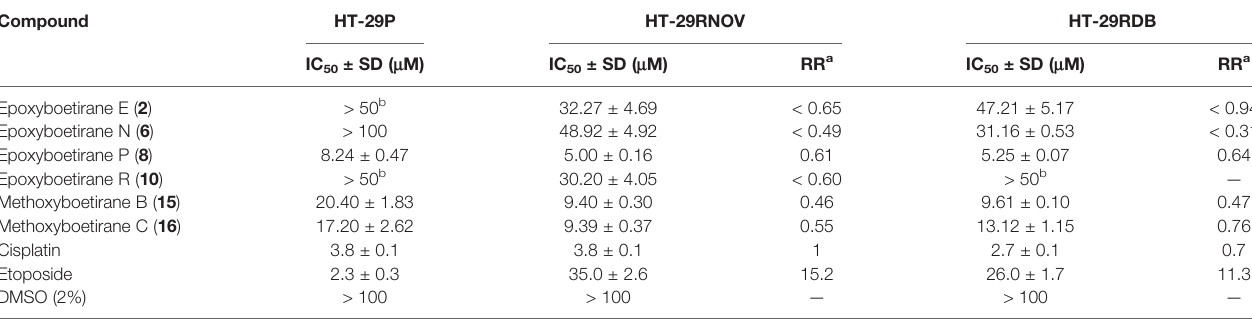
TABLE 4 | Antiproliferative activity of compounds 1 – 16 in colon carcinoma cells HT-29P (parental), HT-29RNOV (multidrug resistance [MDR] phenotype), and HT- 29RBD (multidrug resistance [MDR] phenotype). Compound